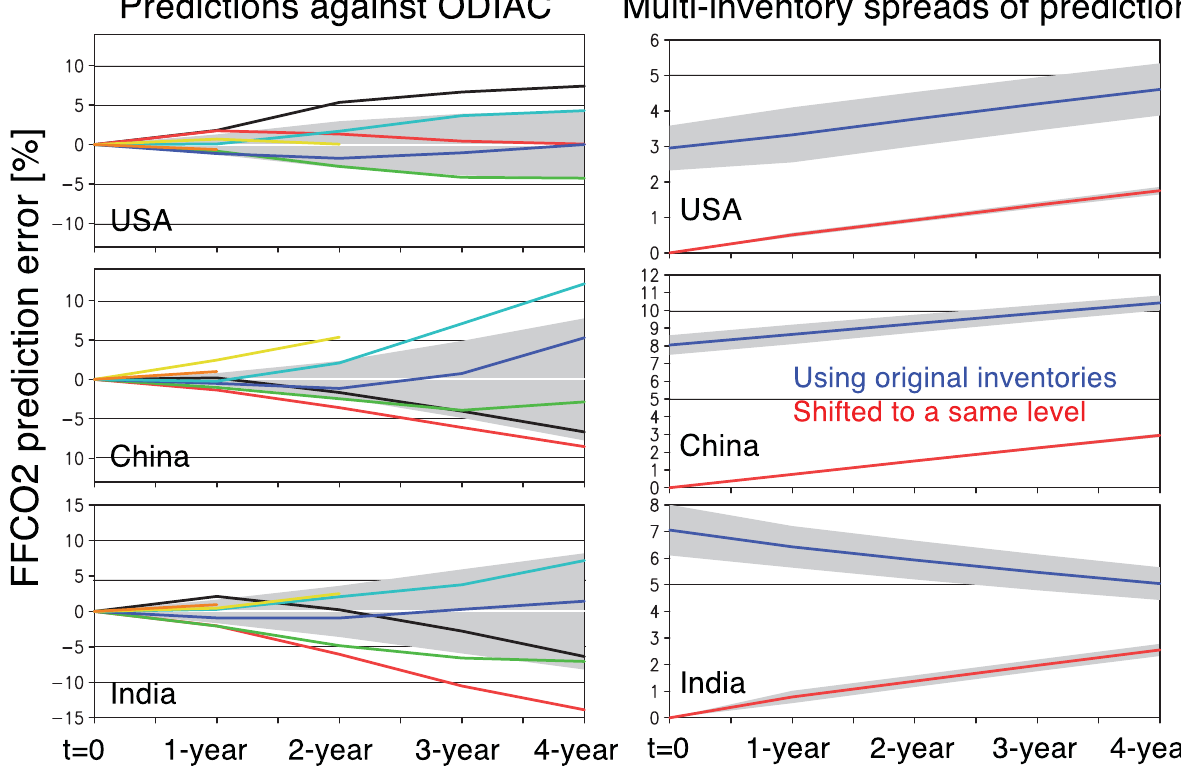
Fig. 7 | Temporal evolution of the Kalman fi lter (KF) prediction errors. (left) Temporal evolution of the Kalman fi lter (KF) prediction errors, starting from each year during 2010 and 2017 (color lines), for the US, China, and India. The shaded area represents the±root-mean-square (RMS) of the prediction errors. (right) The